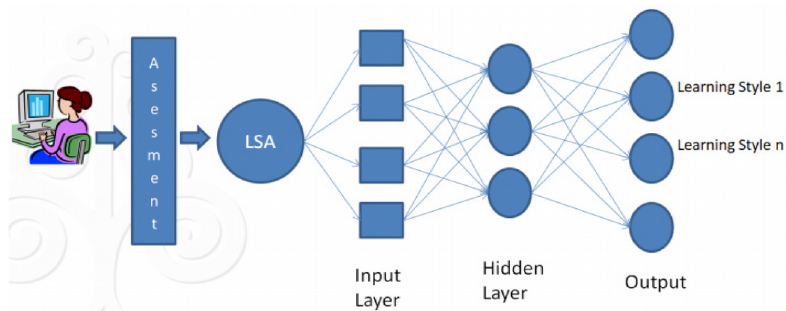
Figure 6. Artificial Neural Network For E-learning